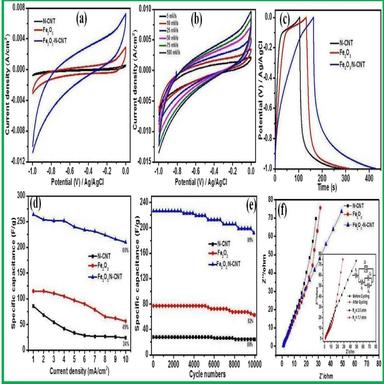
(a) CV curves of N-CNT, bare Fe2O3 and Fe2O3/N-CNT at a scan rate of 50 mV s1 (b) CV curves of Fe2O3/N-CNT at different scan rates (5e100 mV s1 ) in the potential range of 1 to 0 V vs Ag/AgCl in 2 M KOH (c) Galvanostatic charge discharge studies of N-CNT, bare Fe2O3 and Fe2O3/N-CNT at a current density of 1 mA cm2 in the potential range of 1 to 0 V vs Ag/AgCl in 2 M KOH (d) Function of specific capacitance at different current densities of N-CNT, bare Fe2O3 and Fe2O3/N-CNT (e) cycling stability of N-CNT, ba